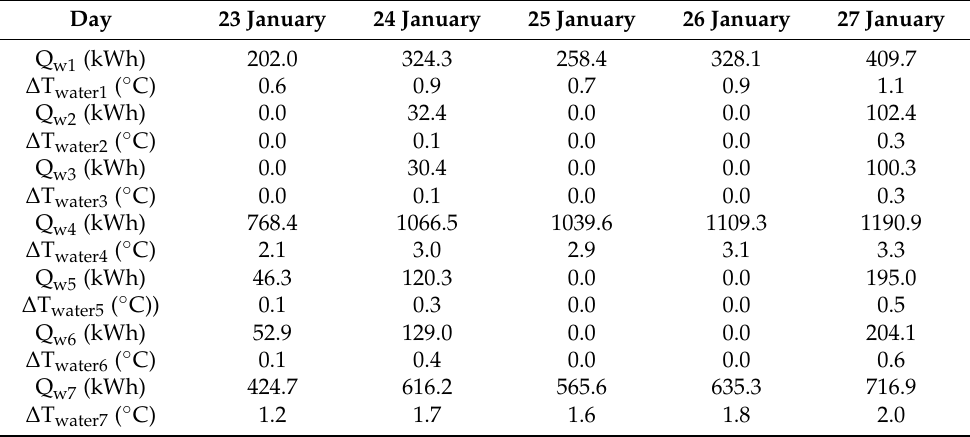
Table 8. Residual heating energy used for the heating of the drinking water after being used for sheep barn heating and the corresponding rise in the drinking water